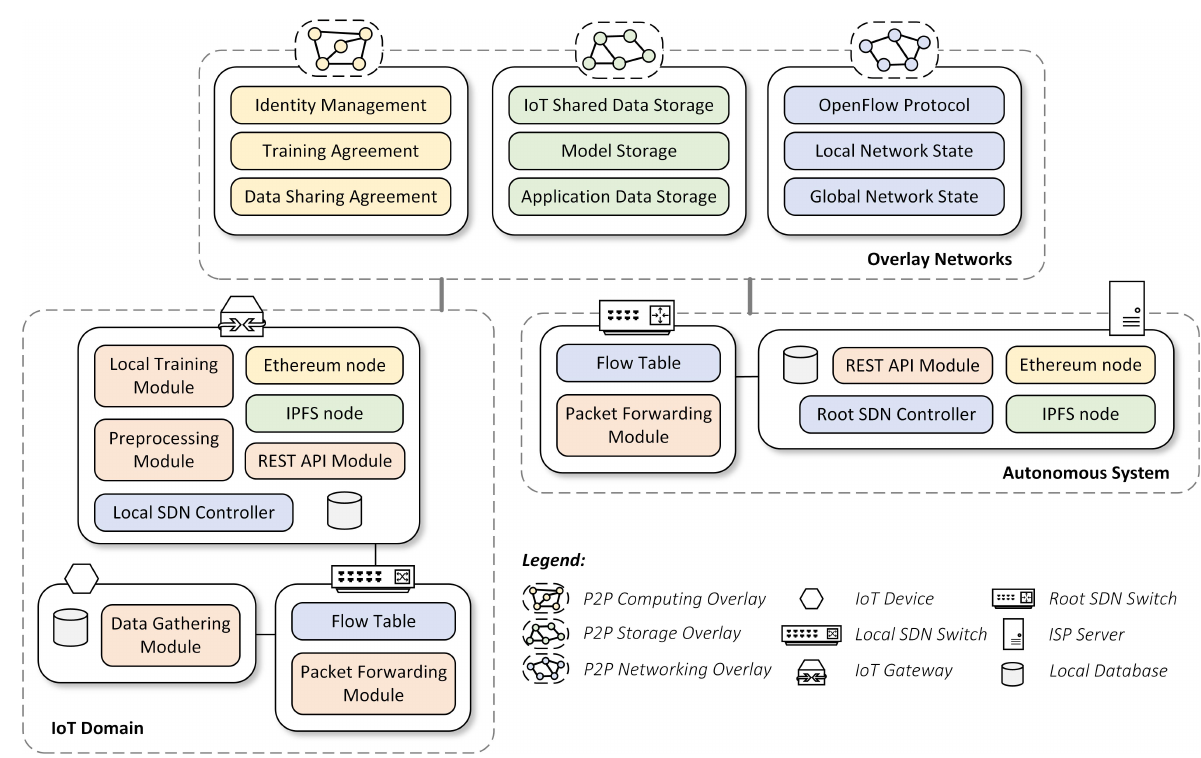
Figure 2. Our conceptual decentralized IoT architecture from a high-level perspective shows the necessary software components each entity needs. Red color indicates local processings while yellow, green, and blue colors are related to P2P Computing, Storage, and Networking Overlay,